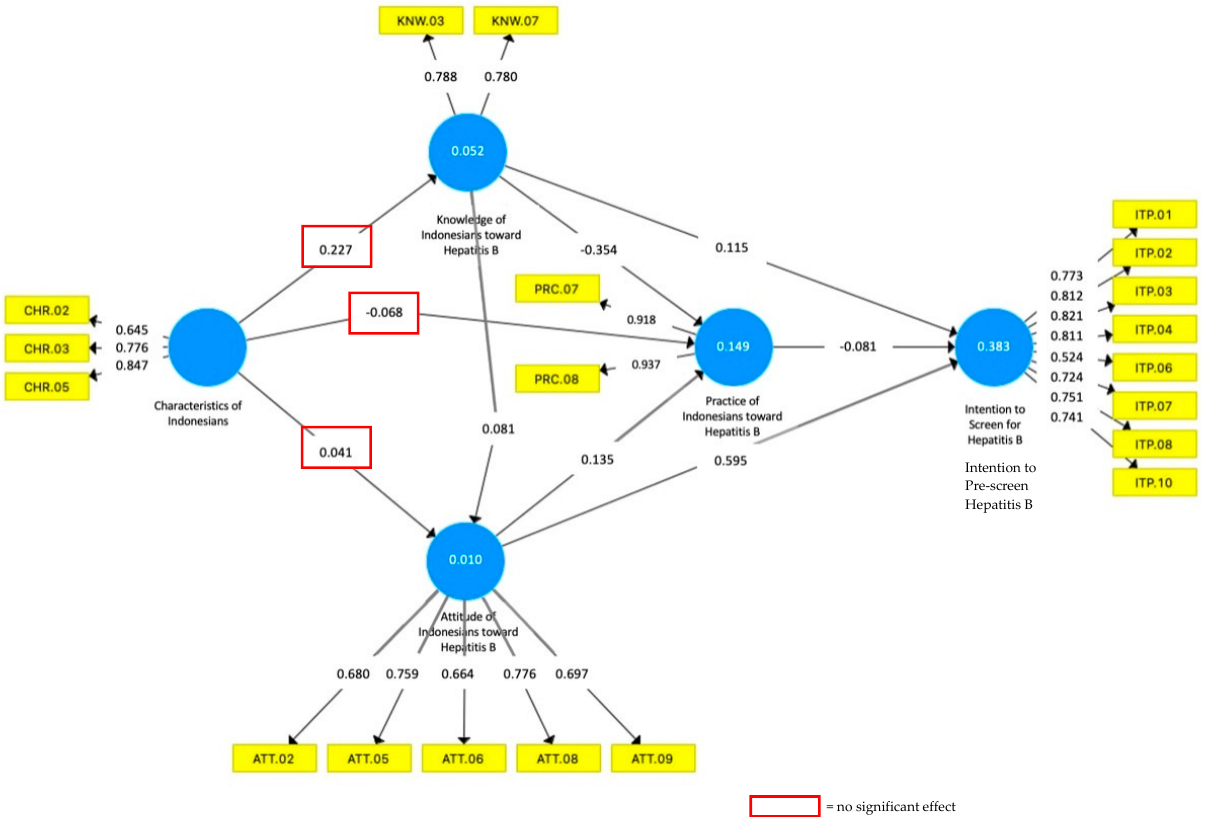
Figure 3. Final Model of the Relationship between Respondents’ Characteristics, Knowledge, Atti- tudes, and Practice of Hepatitis B toward Intention to Screen for Hepatitis B. Values are explained as follows: (1) values inside the lines connecting the blue circle (variable) and yellow boxes (indicators) shows the outer landing value of indicators; (2) values inside the blue circles show the R 2 value, which indicates the endogenous latent variables; and (3) values connecting two blue circles show the path coefficient between two variables. Red boxes indicate no significant effect between the variables based on path analysis of the model.